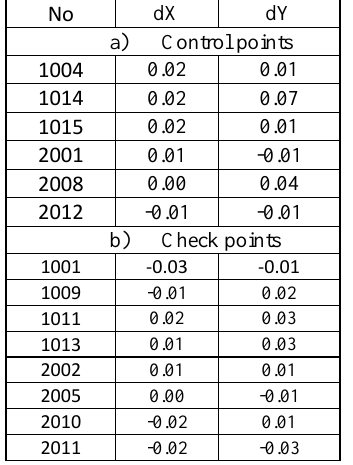
Table 2. Deviation measured on orthomaps and in terrain by GPS technology, on selected points for the classical flight The RMSE on control points was m x = 0,030 m and m y = 0,038 m, the RMSE on check points was m x = 0,014 and m y = 0,031 (table 2) for classic technology. The RMSE on control points was m x = 0,017 m and m y = 0,022 m, the RMSE on check points was m x = 0,019 and m y = 0,022 m (table 4) – for UAV technology.